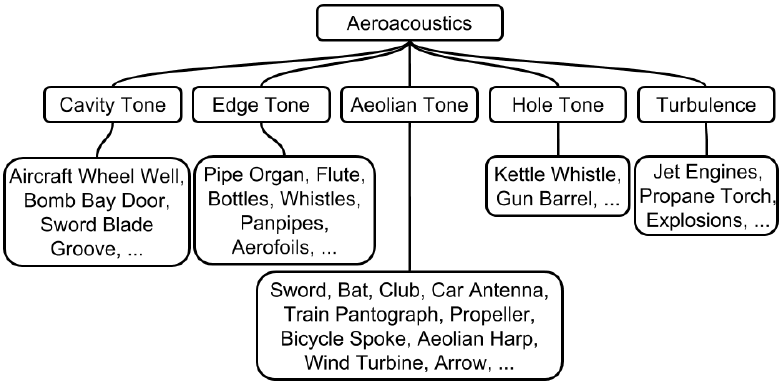
Figure 1. A simplified taxonomy of aeroacoustic